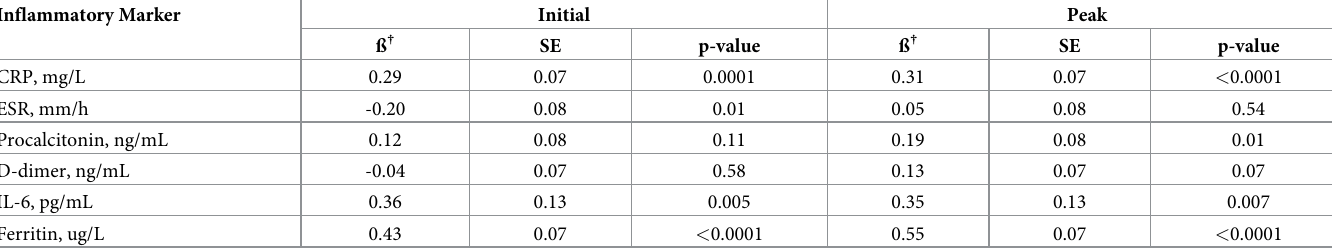
Table 2. Sex as a predictor of initial and peak inflammatory markers.